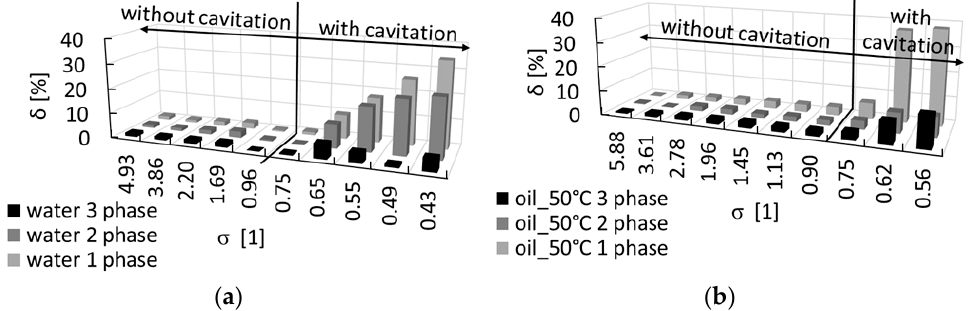
Figure 9. ( a ) Dependence of deviation measurement δ (%) vs. cavitation number σ (1) for water; ( b ) Dependence of deviation measurement δ (%) vs. cavitation number σ (1) for oil.